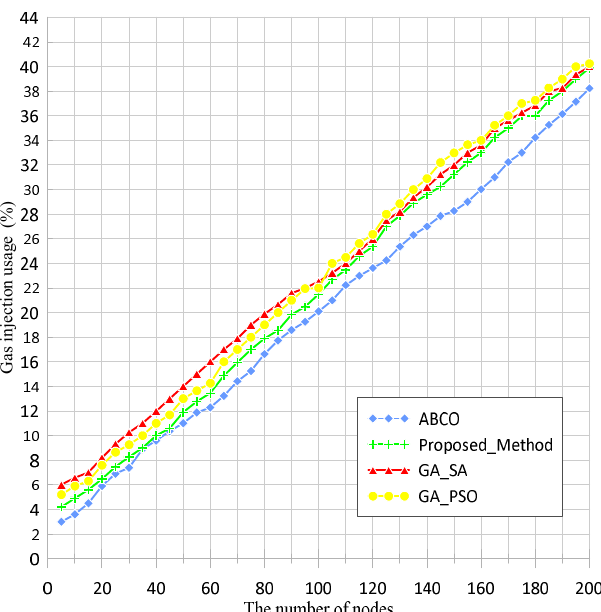
Figure 8. The gas injection of the proposed method and three evolutionary algorithms.